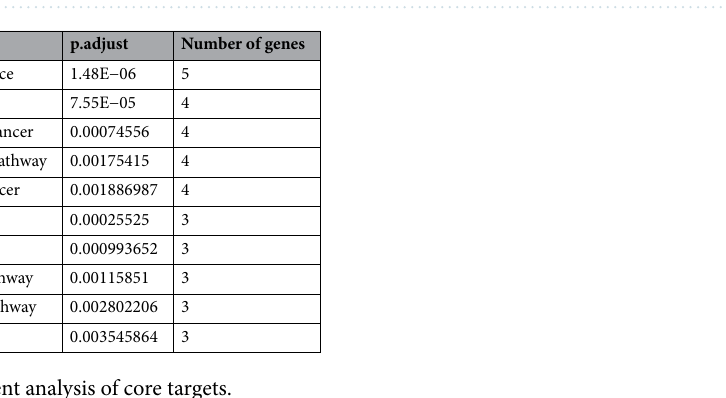
Figure 6. Advanced bubble diagram of KEGG pathway enrichment analysis. By KEGG pathway enrichment analysis, 34 pathways were obtained, and the top 10 important pathways were shown by bubbles through screening.